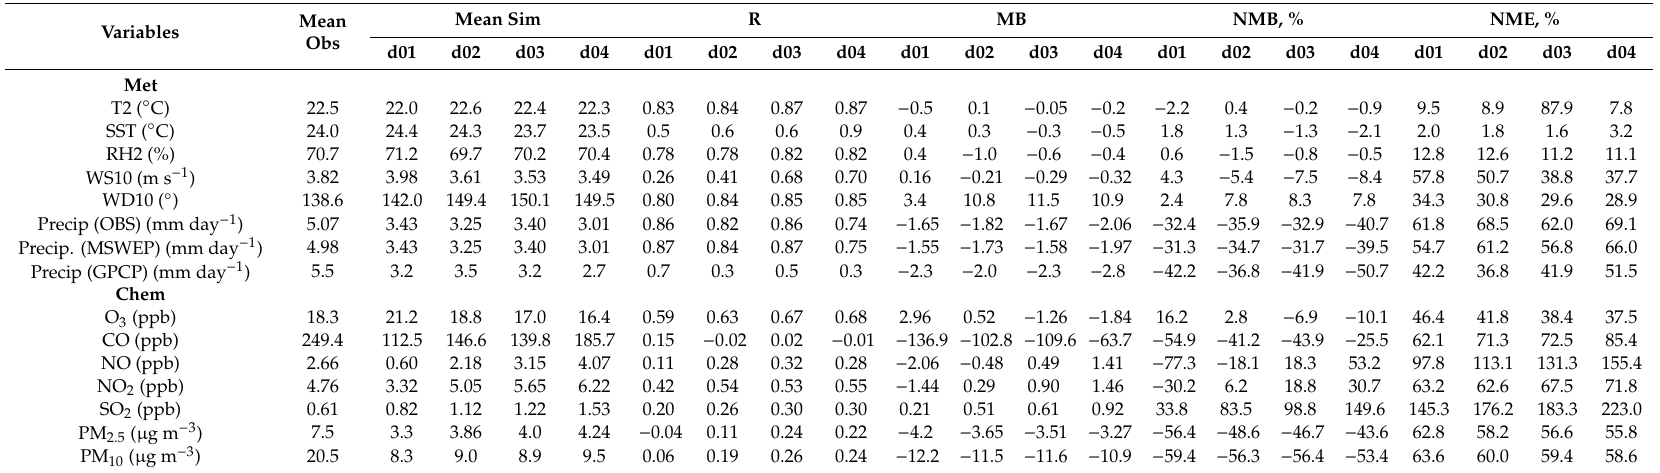
Table 3. Performance statistics of meteorological and chemical variables from WRF / Chem-ROMS simulations at a horizontal grid resolution of 81-km (in d01), 27-km (in d02), 9-km (in d03), and 3-km (in d04) calculated using predictions and observations in d04 for the MUMBA field campaign.